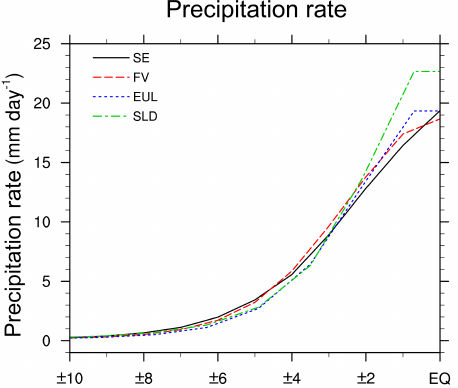
Figure 12. MITC time-mean zonal-mean hemispherically averaged precipitation rates for SE (black), FV (red dashed), EUL (blue dot- ted), and SLD (green dash-dot).